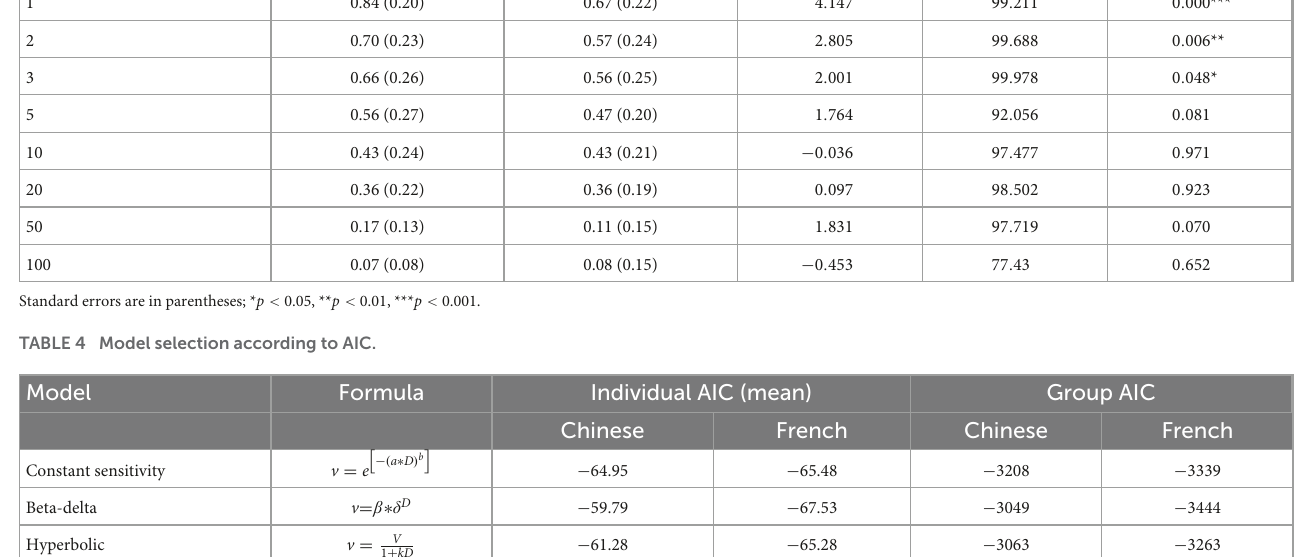
TABLE 3 Proportion of the endowments allocated to recipients at each social distance. Social distance